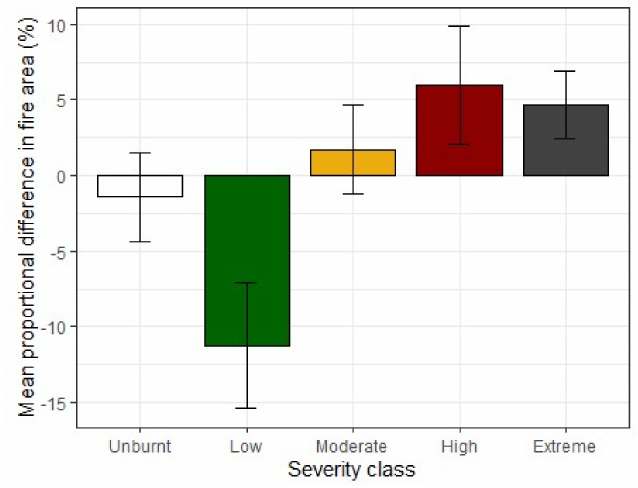
Figure 4. The mean difference in the percent of total fire area in each severity class across all 27 case study fires when mapped with Sentinel 2 compared to Landsat 8.